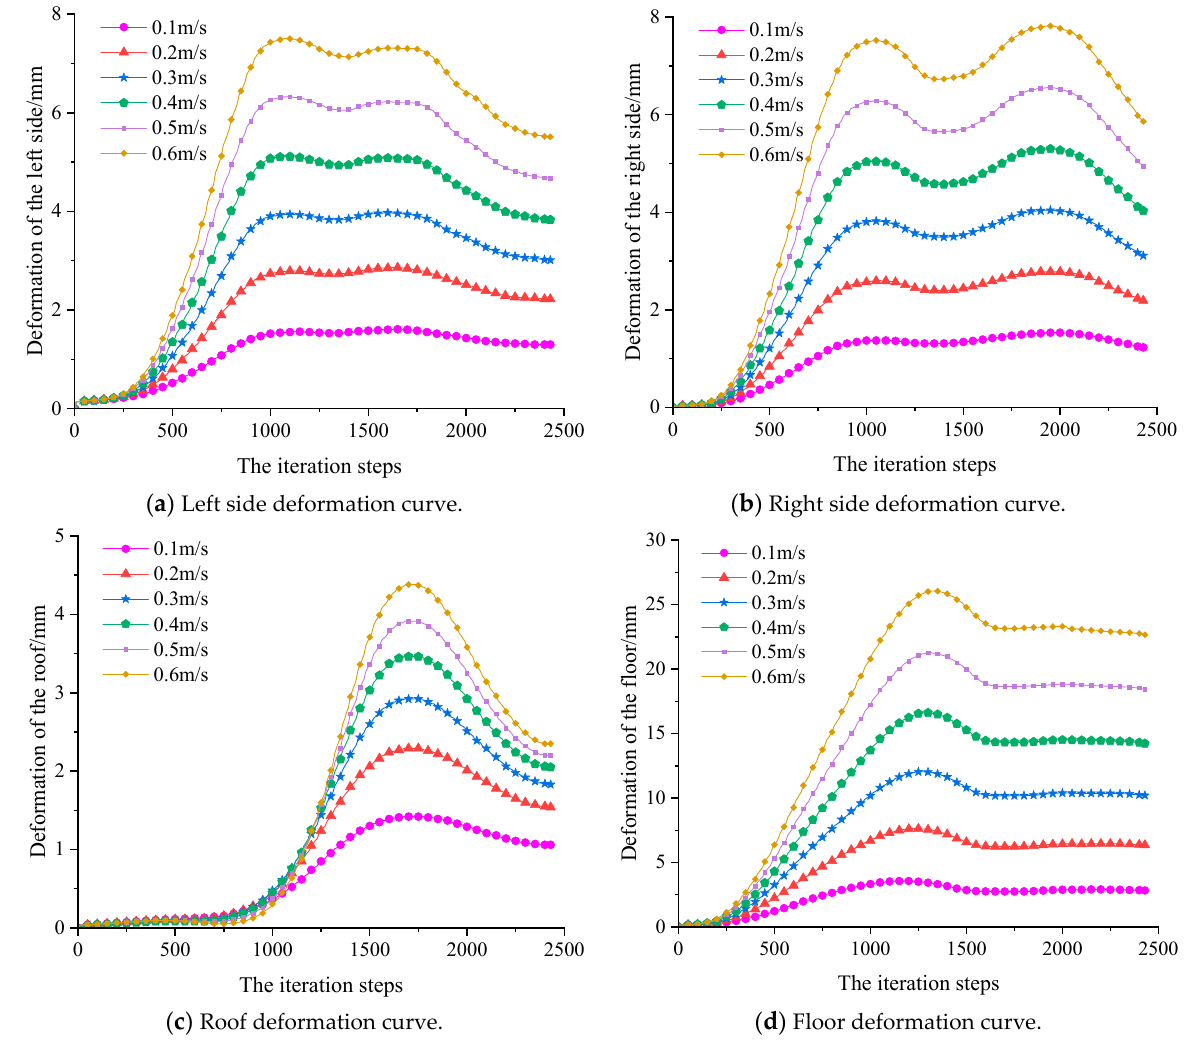
Figure 13. Roadway deformation curve with respect to different PPVs.